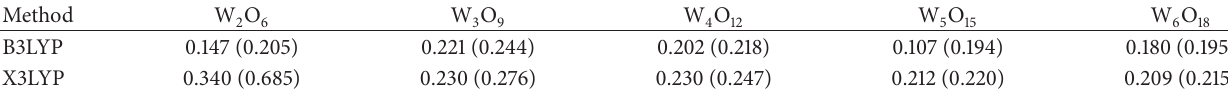
Table 1: Energy of adsorption for all structures (in − eV) and adsorption through O-head (N-head) of NO.